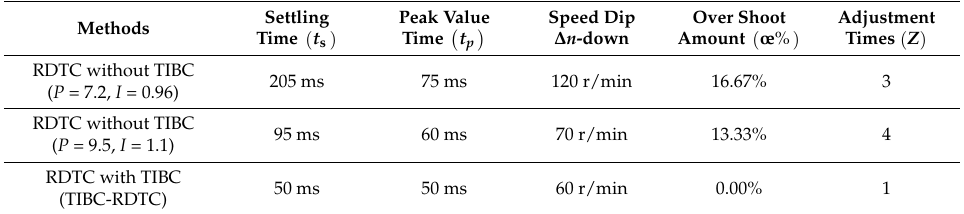
Table 4. Performance metrics of the direct torque control with voltage vector reconstruction (RDTC) without torque impulse balance control (TIBC ) and with TIBC.